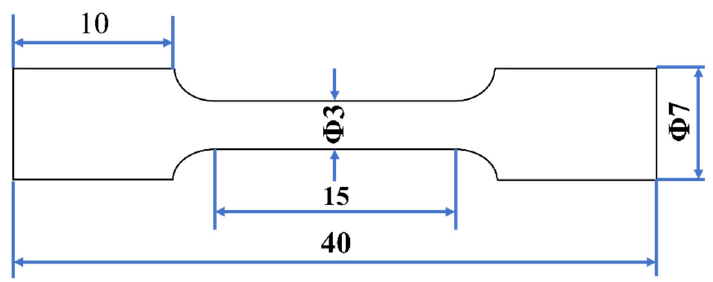
Figure 2. Schematic diagrams of tensile samples (in mm).